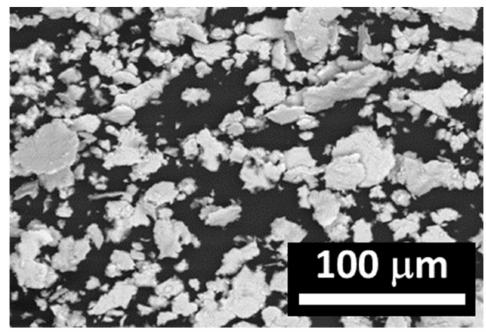
Figure 2. Carbonyl nickel microparticles.